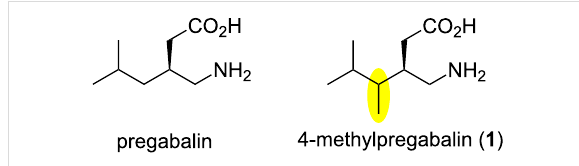
Figure 1: Structures of pregabalin and